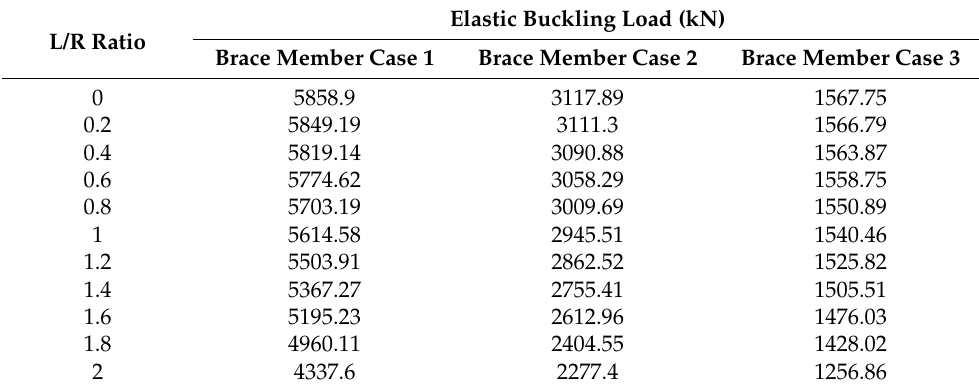
Table 13. The elastic buckling loads for braced longitudinal columns.